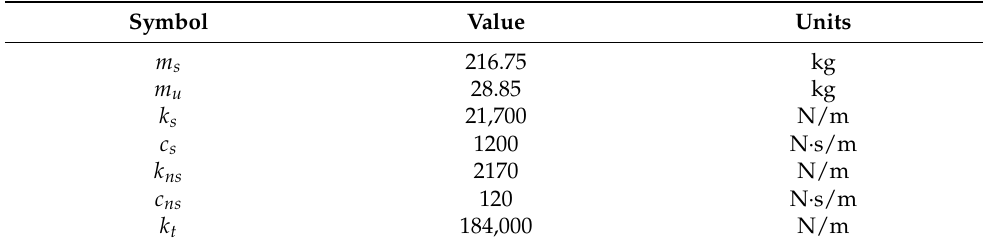
Table 1. Constant Values of the Active Suspension system.